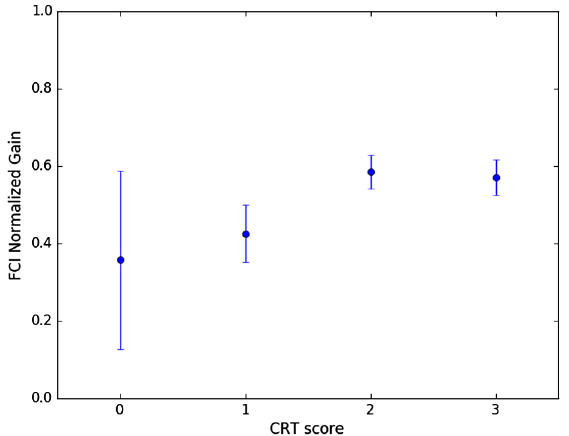
FIG. 2. Median FCI normalized gain versus CRT score. Uncertainties are standard error on the